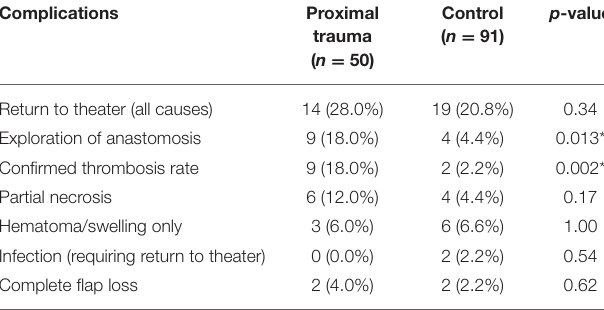
TABLE 4 | Choice of recipient vein/s for free flap.